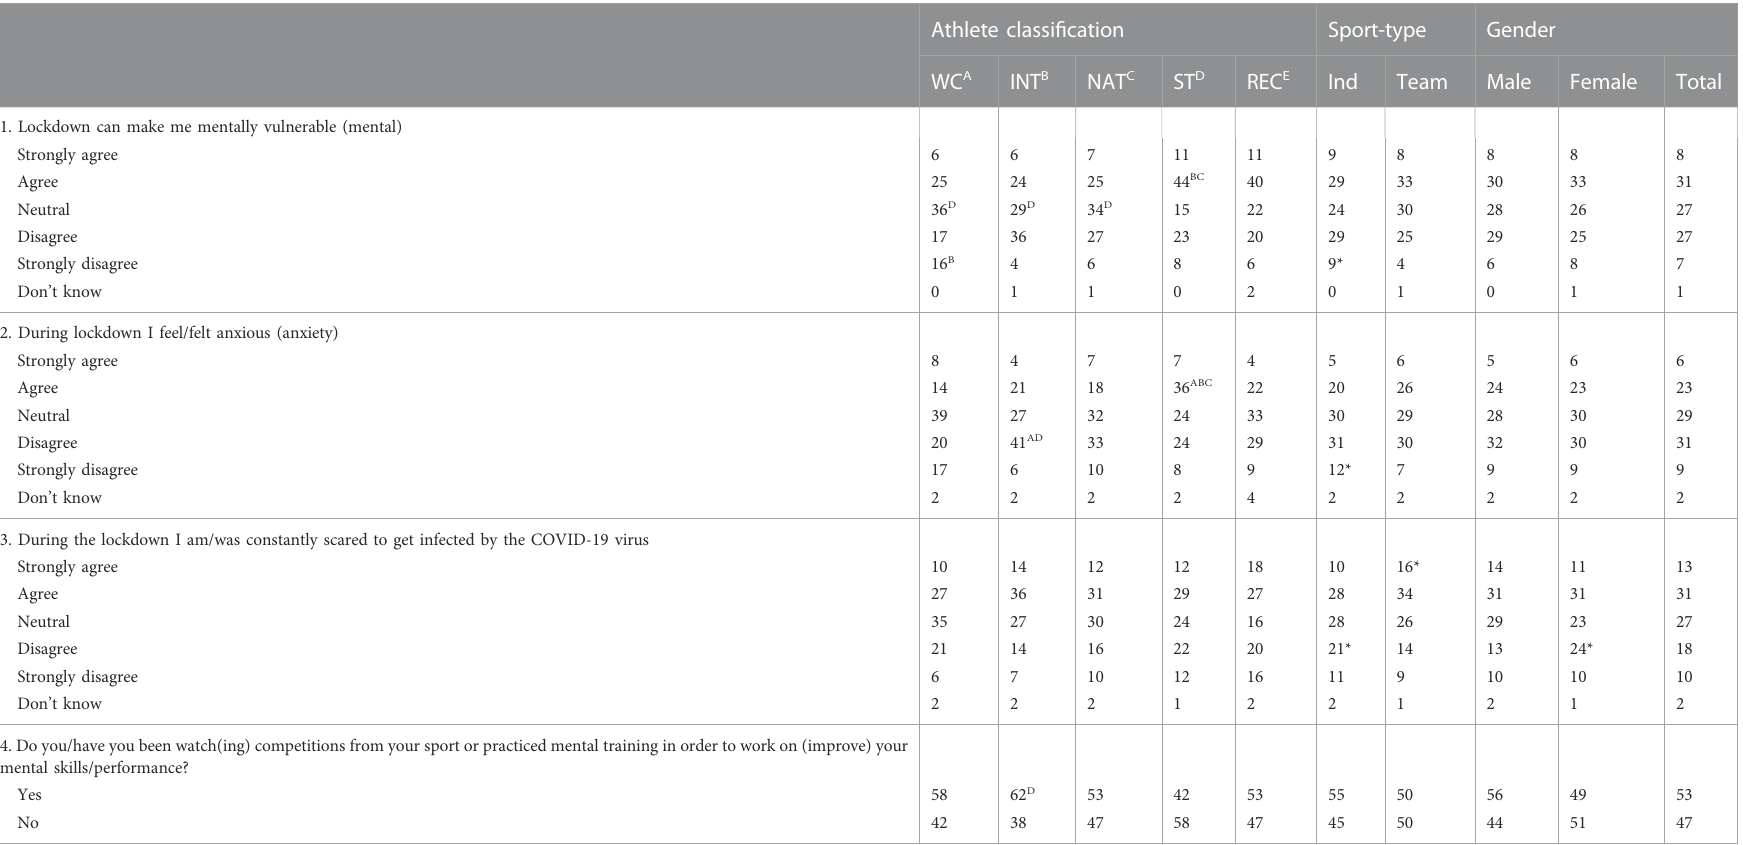
TABLE 4 Athletes ’ psychological responses by athlete classi fi cation, sport-type, gender, and total cohort, during a COVID-19 lockdown in Malaysia (percentage of